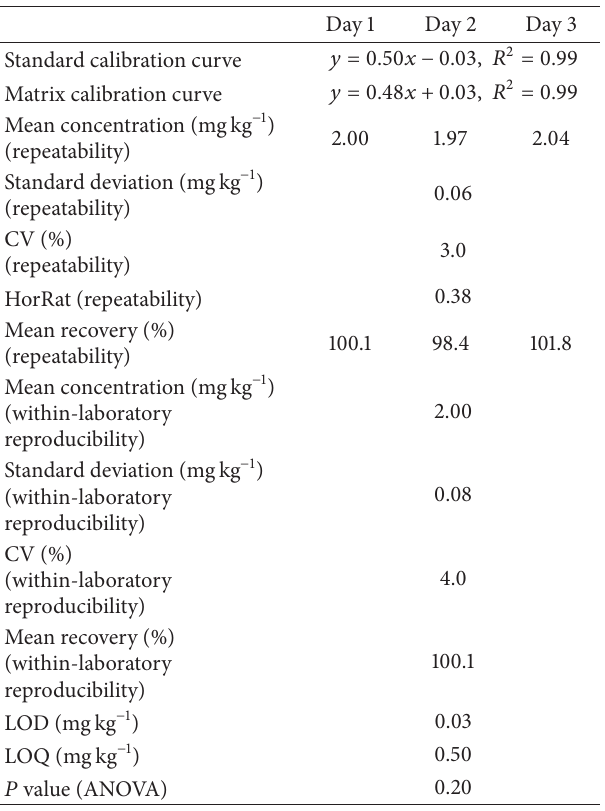
Table 1: Validation results.